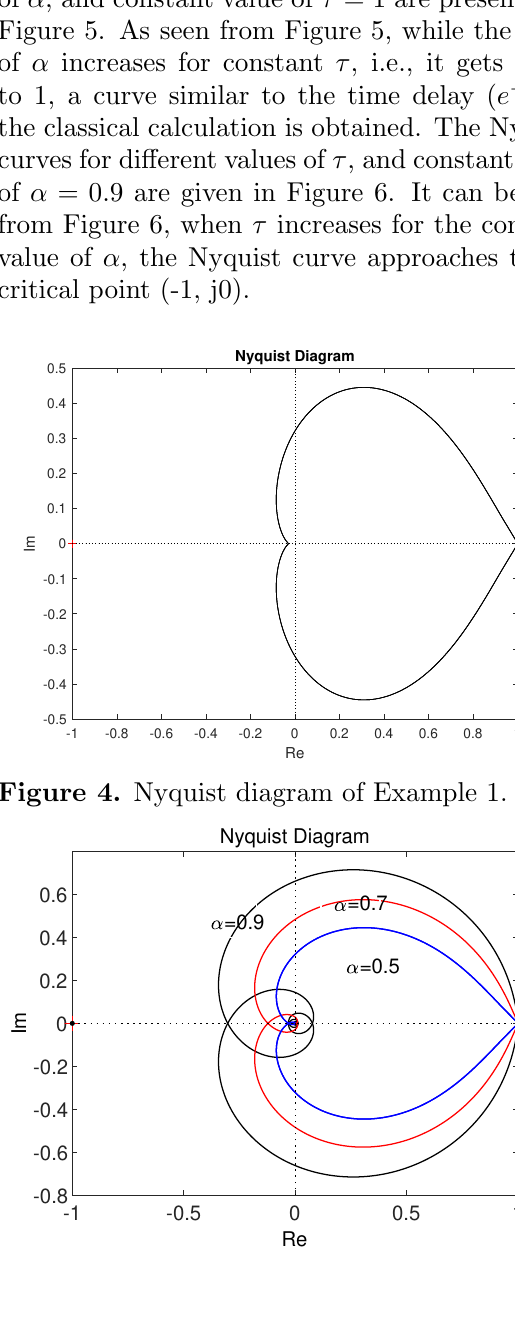
Figure 6 . Nyquist diagram of Example 1 for dif- ferent values of τ , and fixed α = 0 .